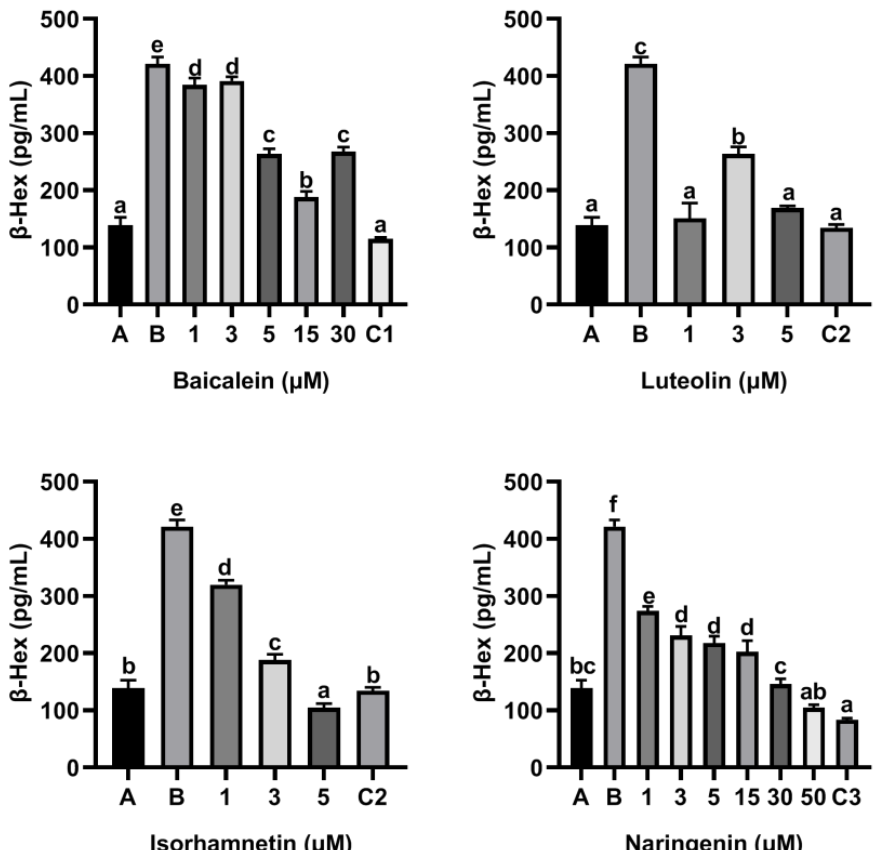
Figure 3. Effect of four flavonoids on the release of β -Hex from KU812 cells induced by ω -5 gliadin- derived peptide P4. A (blank group): Only KU812 cells; B (control group): 150 µ g/mL ω -5 gliadin- derived peptide P4+KU812 cells; C1 (positive control group): 30 µ M ketotifen fumarate + KU812 cells; C2 (positive control group): 5 µ M ketotifen fumarate + KU812 cells; C3 (positive control group): 50 µ M ketotifen fumarate + KU812 cells. Note: different letters indicate significant differences between groups ( p < 0.05).